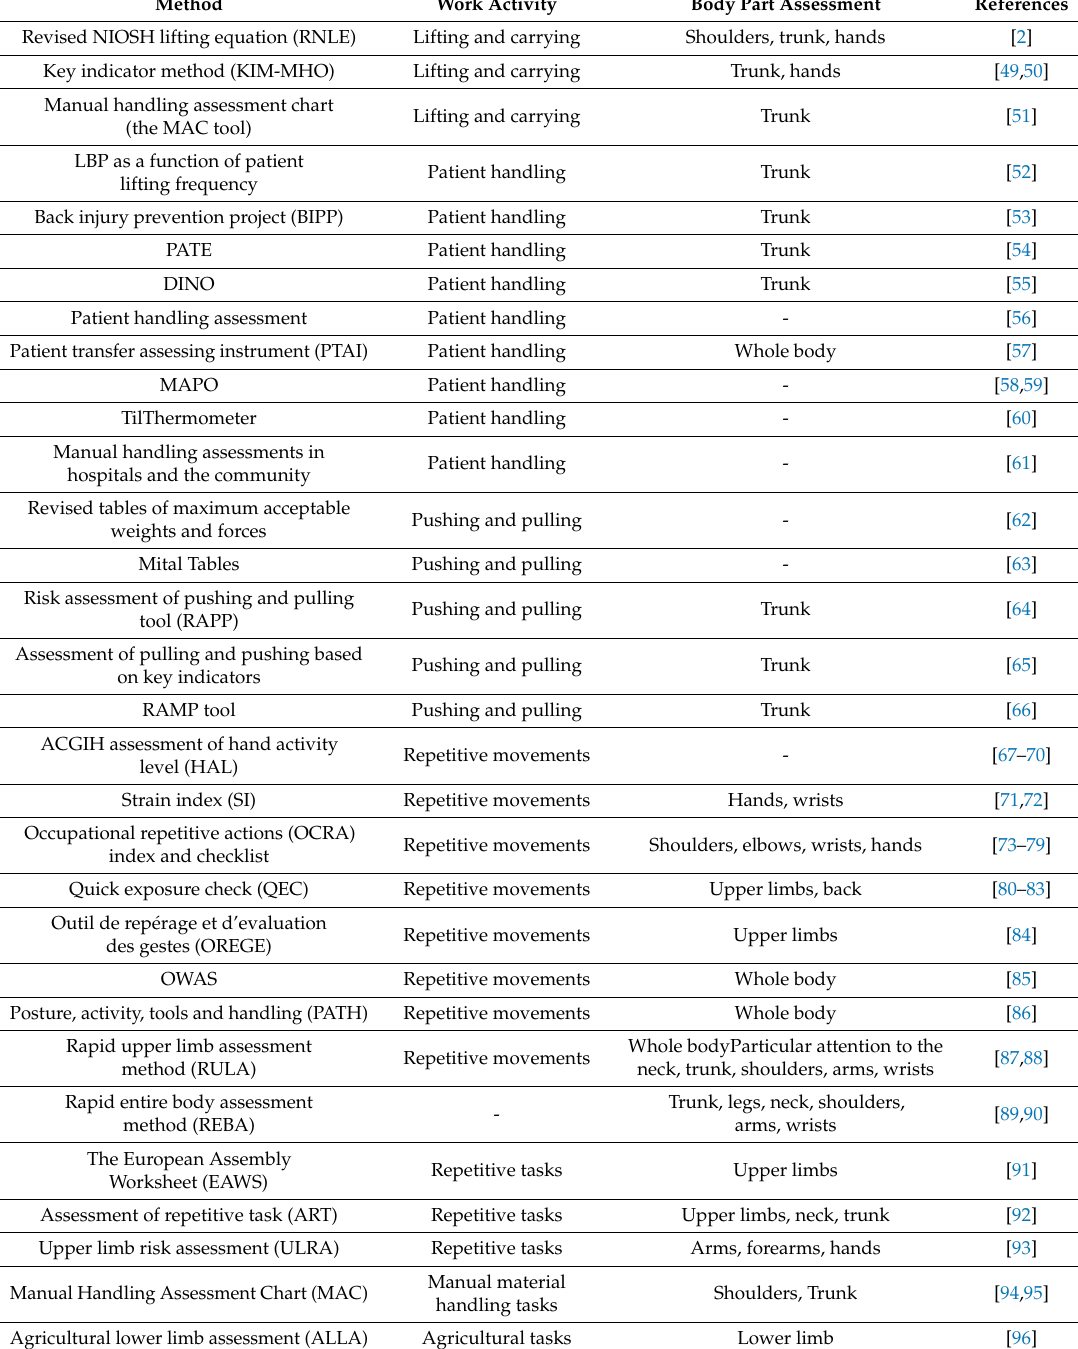
Table 1. Methods used for biomechanical risk